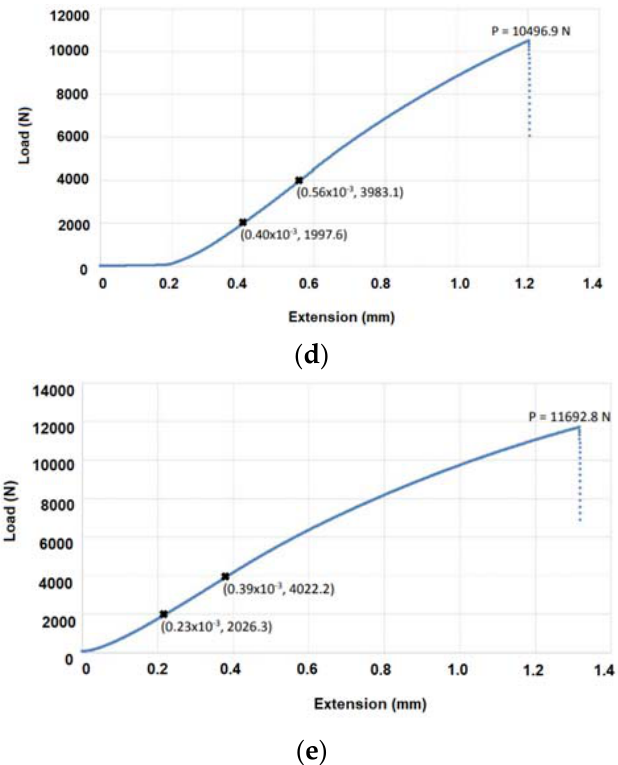
Figure 22. Load extension diagrams as the results of three-point flexure tests for different specimens, including ( a ) specimen No. 2, ( b ) specimen No. 3, ( c ) specimen No. 5, ( d ) specimen No. 6, and ( e ) specimen No. 7. Table 10. Calculated mechanical properties for different